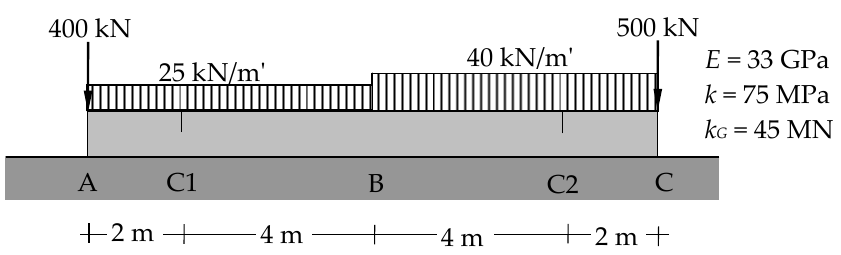
Figure 2. Cracked beam resting on elastic soil.